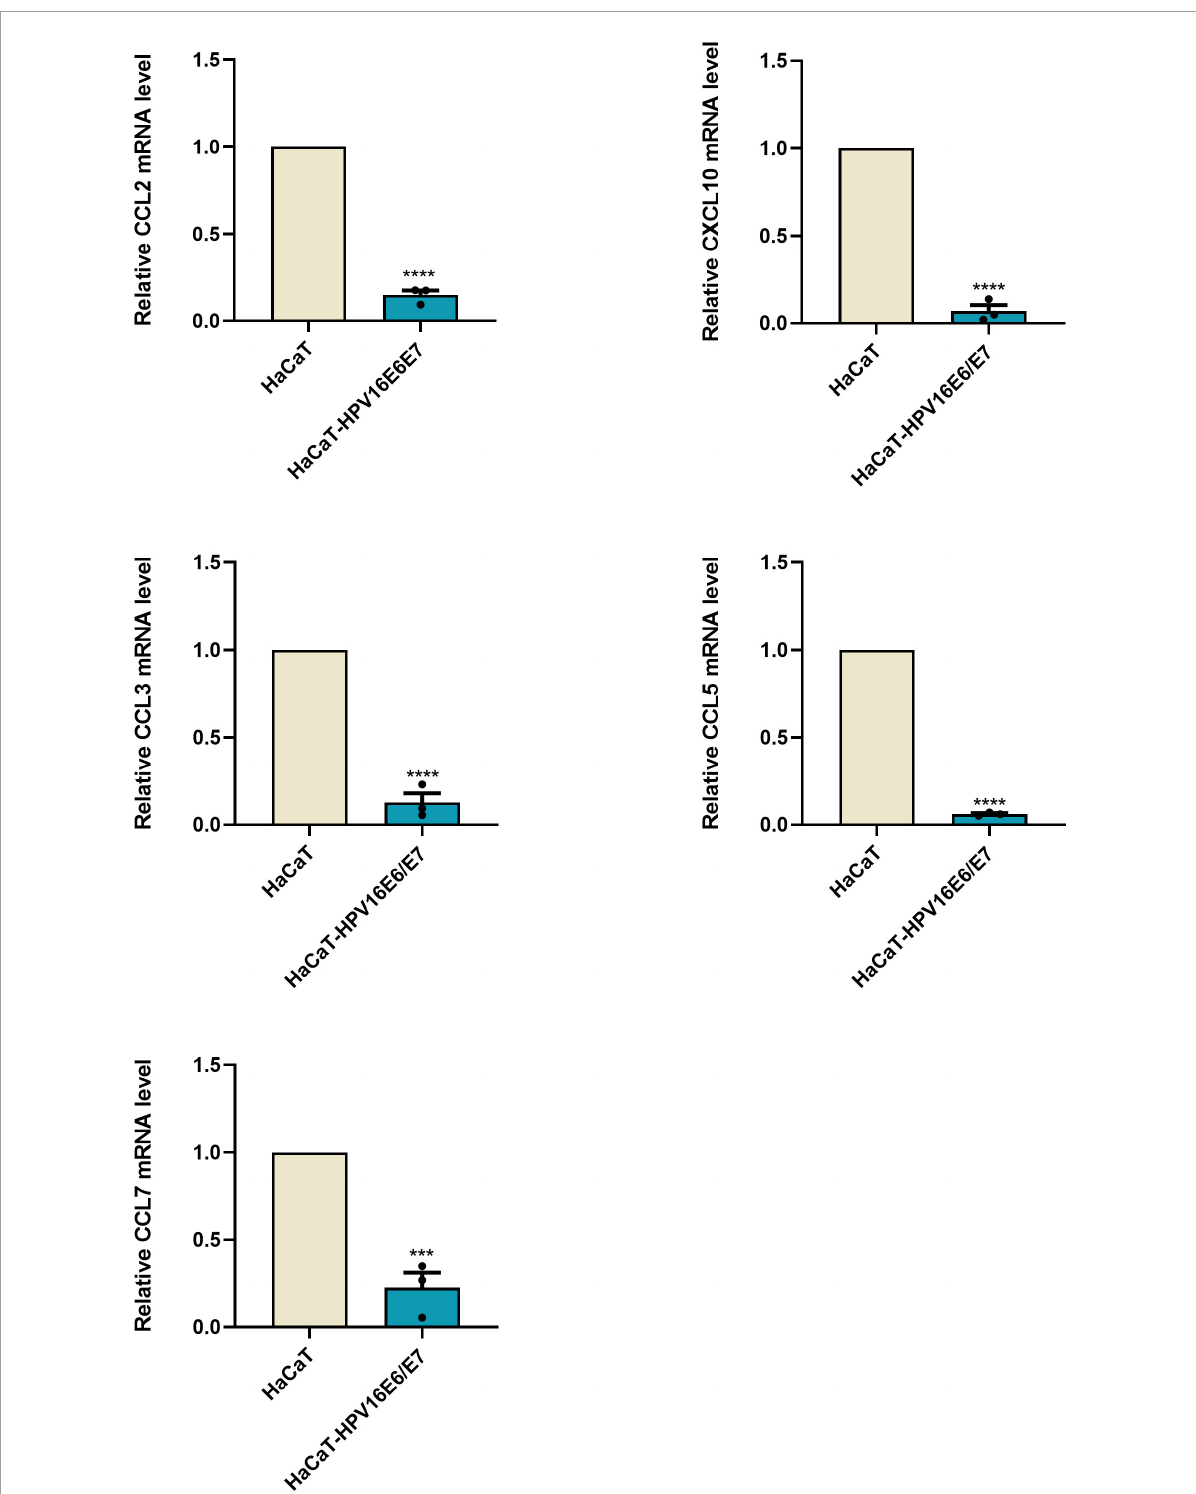
FIGURE2 E6 and E7 damaged the secretion of chemokines in HaCaT RT-qPCR results were quantified by real-time PCR using GAPDH and β -ACTIN as internal control genes and presented in bar graph. It can be seen that overexpression of E6E7 does lead to a decrease in the relative expression of CCL2, CCL3, CCL5, CCL7, and CXCL10. *** p < 0.001, **** p <